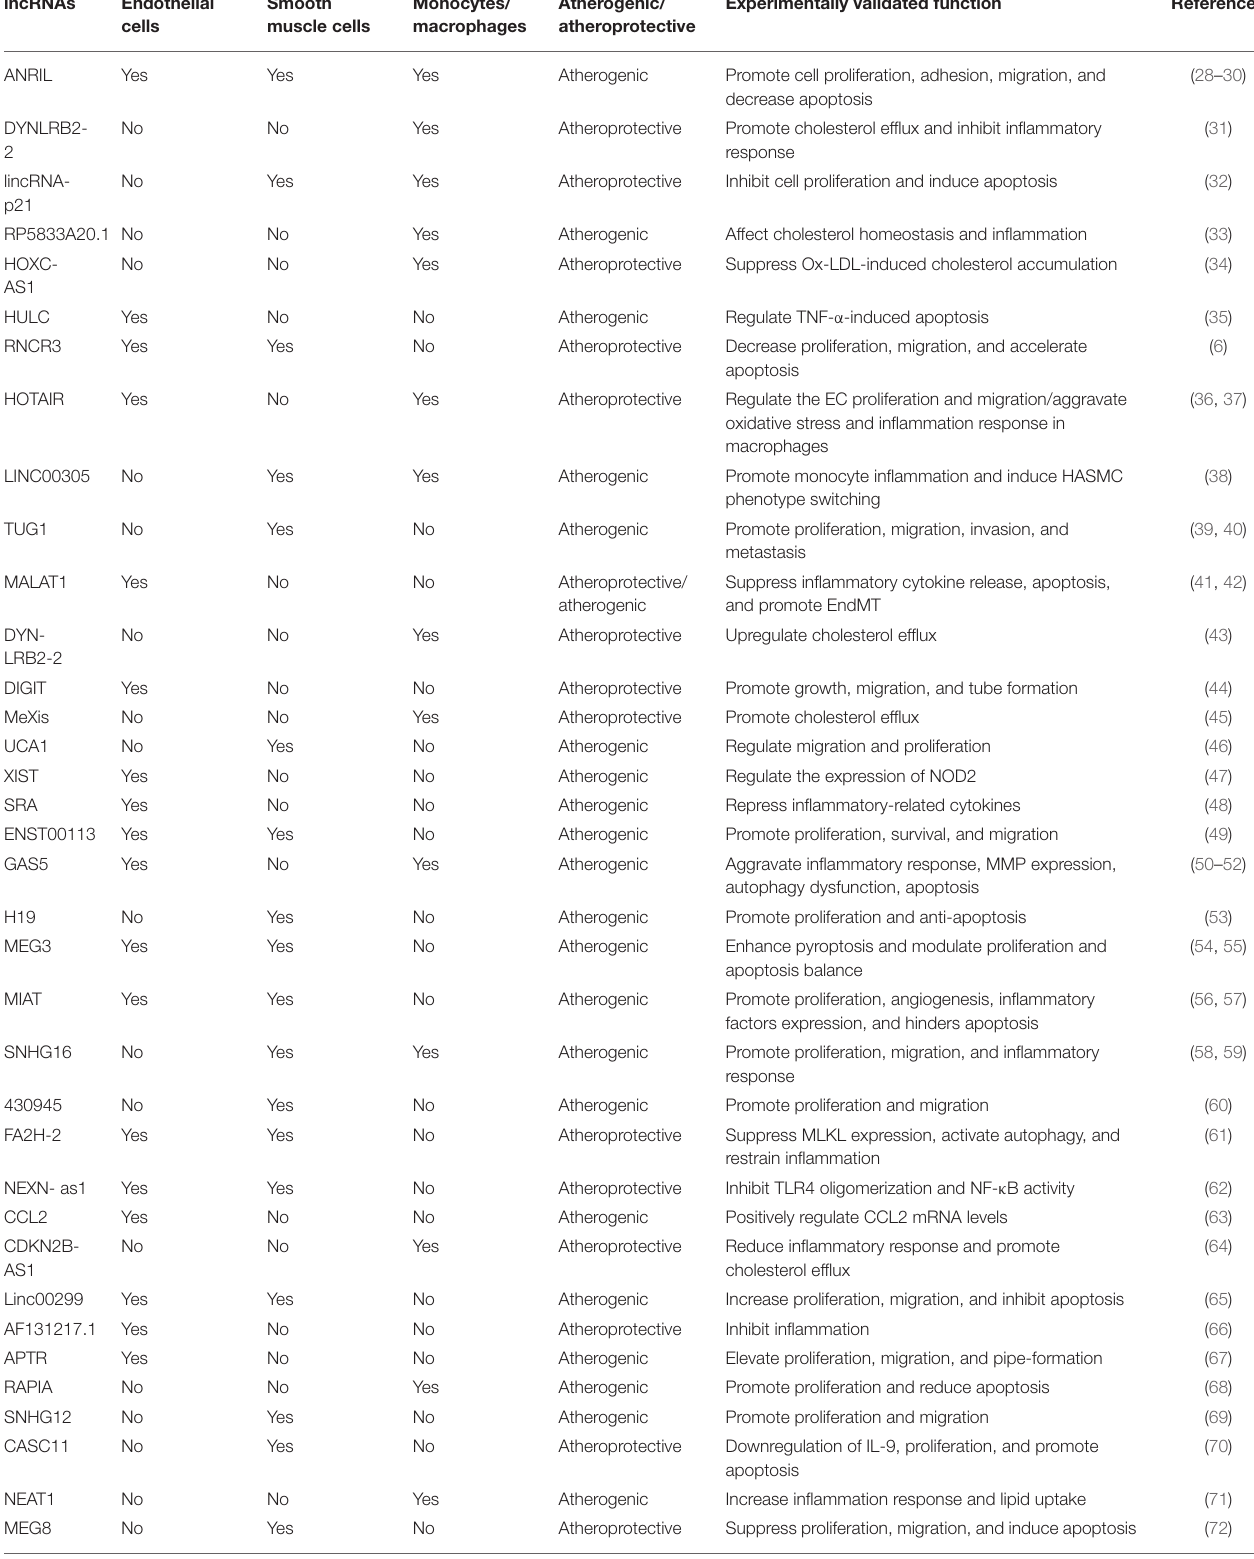
TABLE 1 | Long non-coding RNAs in atherosclerosis-related research.